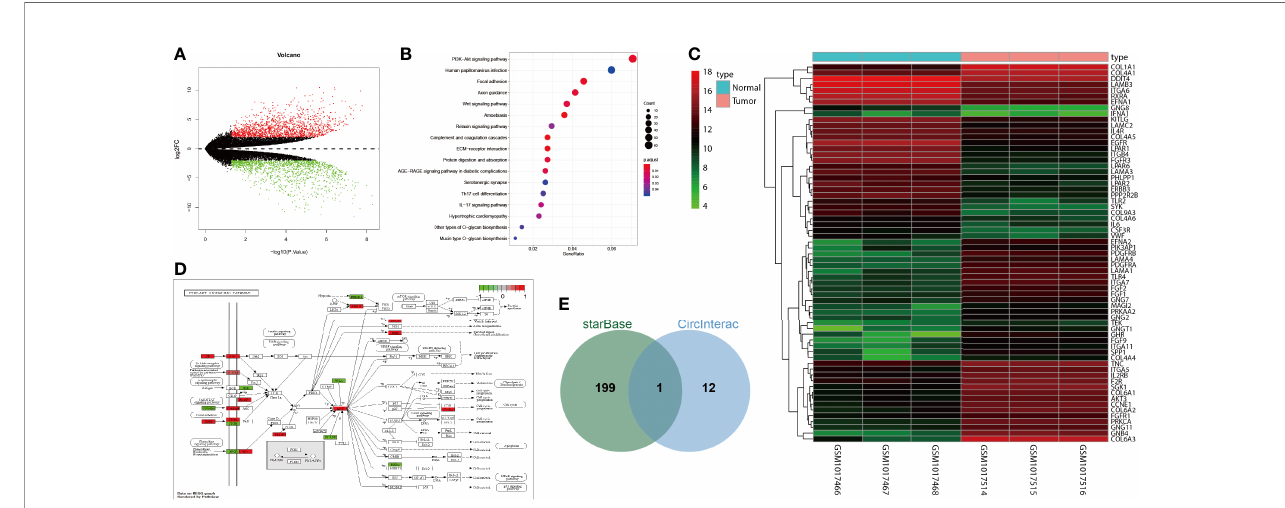
FIGURE 1 | circNRIP1 might be involved in the osteosarcoma development via alteration of miR-532-3p and AKT3. (A) A volcano of differentially expressed genes analyzed by the osteosarcoma-related GSE41445 dataset. The abscissa represents -log10 p value, and the ordinate represents log2FC; each point in the graph represents a gene in which the red point represents signi fi cantly highly expressed genes in osteosarcoma, and the green point represents signi fi cantly poorly expressed genes in osteosarcoma. (B) KEGG enrichment analysis of differentially expressed genes. The abscissa represents GeneRatio, and the ordinate represents KEGG entry; the circle size in the graph represents the number of genes enriched in the entry, and the color represents p value. (C) A volcano of differentially expressed genes in the PI3K/AKT signaling pathway. The abscissa represents sample number, and the ordinate represents gene name; the left dendrogram represents gene expression cluster, each small square represents the expression of a gene in a sample, and the upper right histogram is color scale. (D) Labeling of differentially expressed genes in the PI3K/AKT signaling pathway. Green box represents signi fi cantly poorly expressed genes in osteosarcoma, and red box represents signi fi cantly highly expressed genes in osteosarcoma. (E) Intersection of AKT3 upstream regulatory miRNAs and circNRIP1 downstream regulatory miRNAs. The central part represents the intersection of two groups of